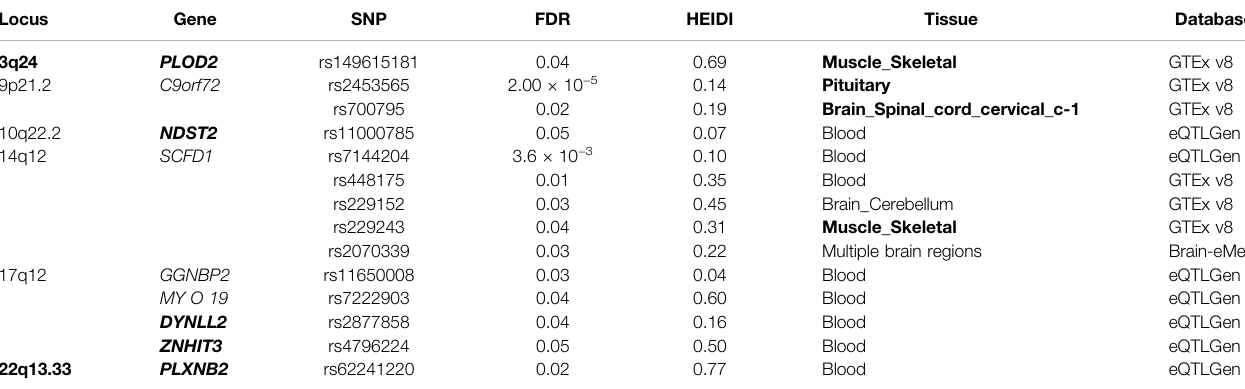
TABLE 1 | Genes mediating the genetic associations with ALS in six loci from SMR and HEIDI analyses.